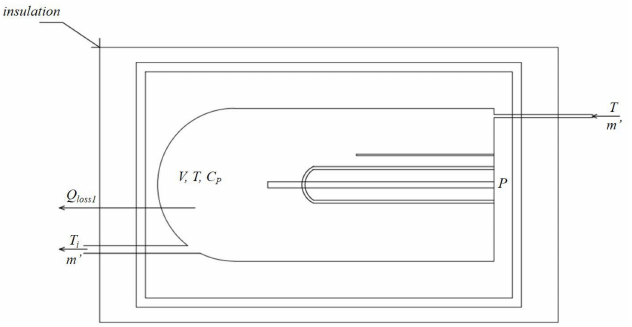
Figure 2. Model of a single-tank water heater showing flow rate, energy, temperature and